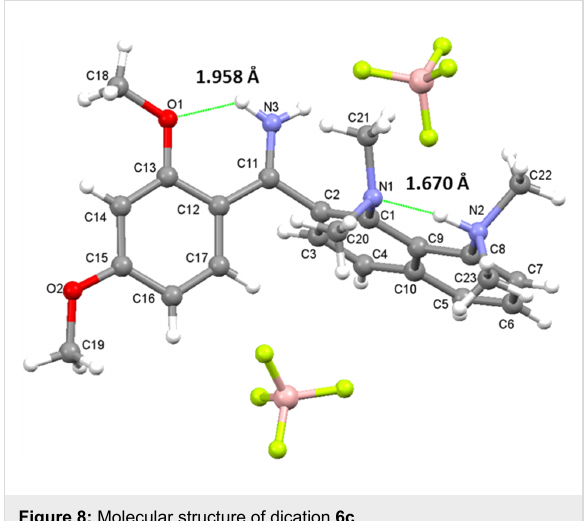
Figure 8: Molecular structure of dication 6 с .